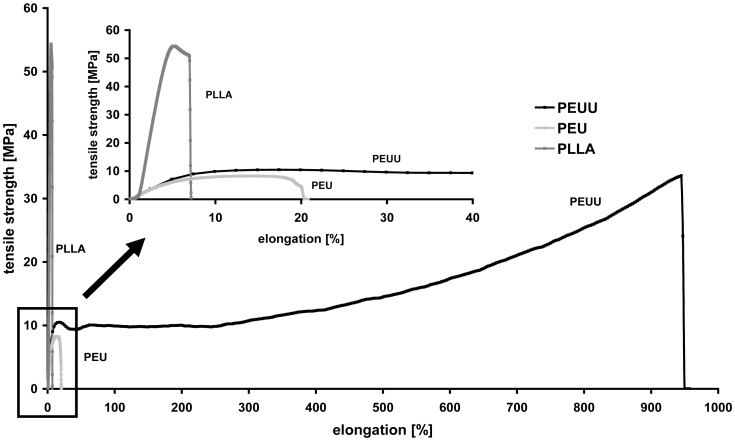
Stress-Strain curves of PEU and PEUU foils in comparison to conventional PLLA foils.